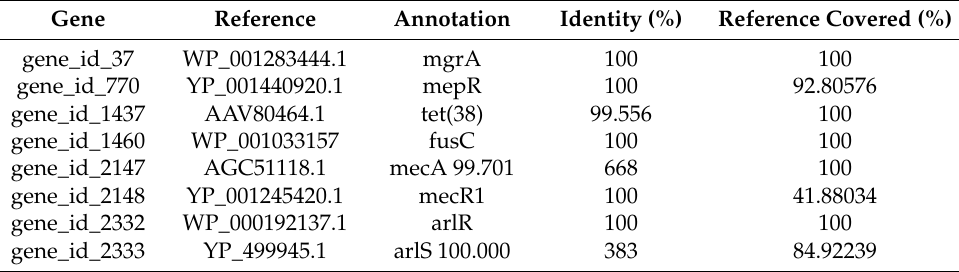
Table 4. List of genes with hits to the CARD database based on similarity